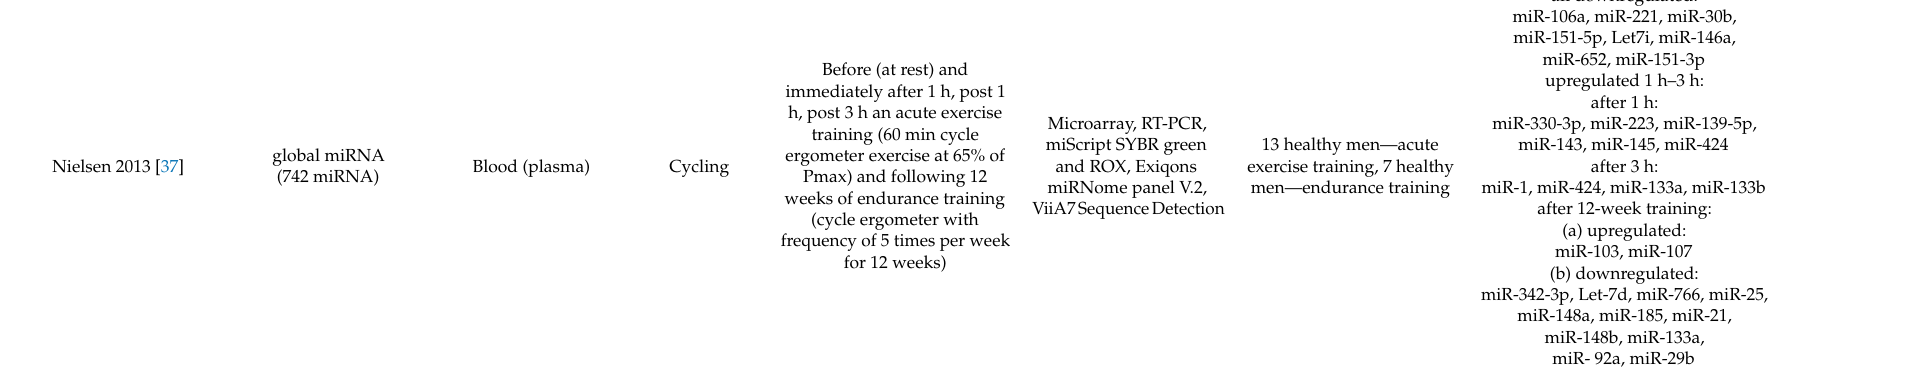
Protocol 3 vs. control: miR-21 In serum EVs: Protocol 2 vs. control: miR-21,